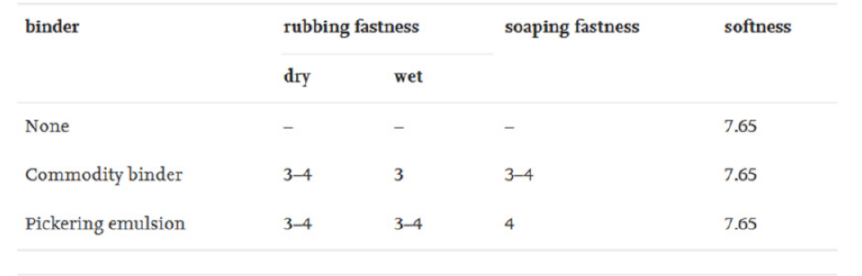
Figure 18. The application results of pigment printing. Reproduced from [122] with permission from the Elsevier B.